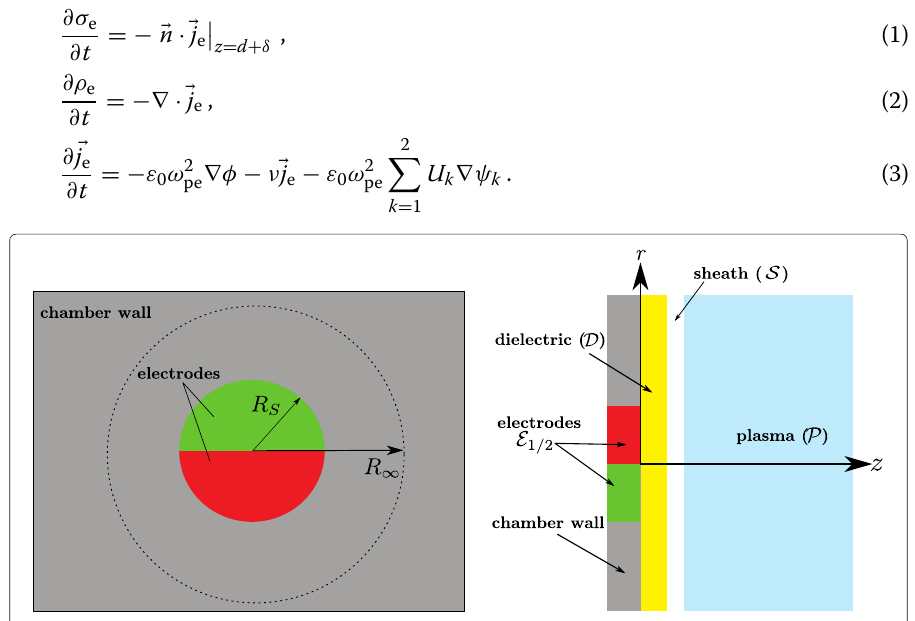
Fig. 3 The pMRP consists of two circular half-disc electrodes E 1 / 2 with radius R S integrated into the chamber wall. A dielectric D covers the electrodes and the chamber wall. The sheath S in front of the dielectric separates it from the plasma